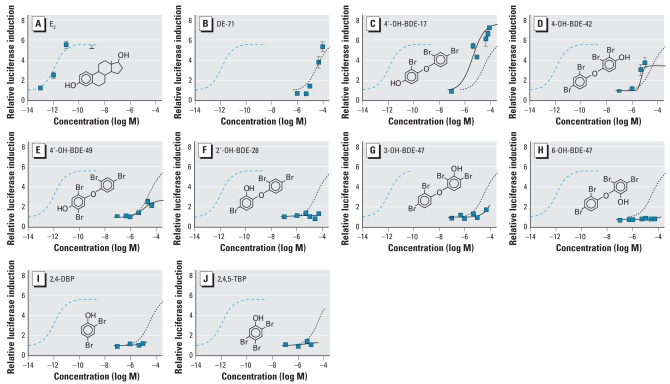
ERE-luciferase induction by E2 (A), DE-71 (B), and the OH-BDEs 4′-OH-BDE-17 (C), 4-OH-BDE-42 (D), 4′-OH-BDE-49 (E), 2′-OH-BDE-28 (F), 3-OH- BDE-47 (G), 6-OH-BDE-47 (H), 2, 4-DBP (I), and 2, 4, 5-TBP (J). See “Material and Methods” for details. Each curve for an OH-BDE represents the mean of 3–6 independent dose–response studies, except 6-OH-BDE-47, for which only 2 assays were performed. Curves for DE-71 and E2 are the mean of 12 and 8 independent dose–response studies, respectively. Error bars indicate SE. All values are normalized to vehicle control (DMSO = 1). Modeled data for E2 (dashed blue line) and DE-71 (dotted line) are shown in all OH-BDE charts for comparison. Modeled data for each OH-BDE are shown as a solid line.